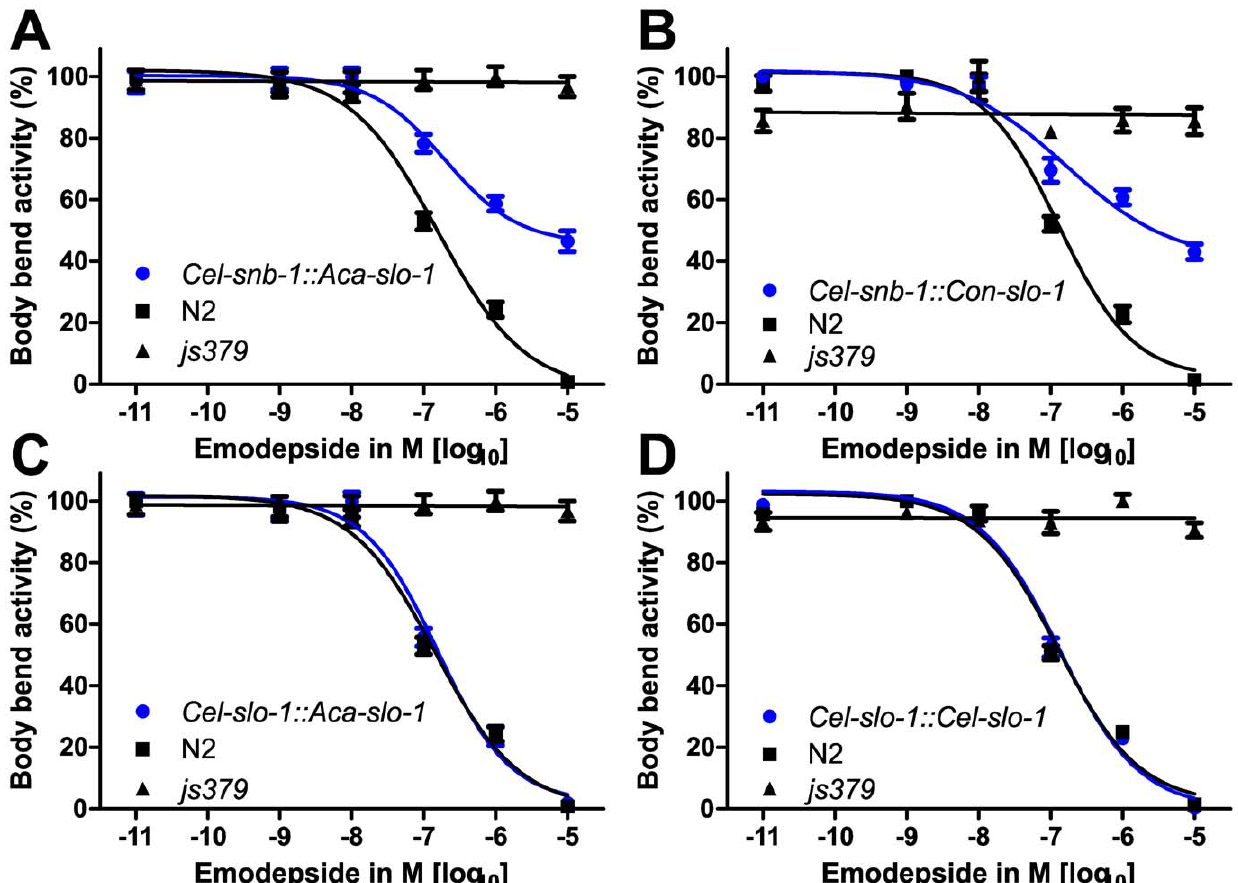
Figure 3. Parasite SLO-1 expressed from C.elegans promoters recover emodepside susceptibility in resistant slo-1 loss-of-function mutants. Body bend activity in percent (relative to the highest number of body bends in that group) of young adults after 24 h exposure to N emodepside. Comparison of wild-type N2, emodepside-resistant strain slo-1(js379) , and transformed slo-1(js379) lines. Error bars represent standard ) represent transformed lines, squares ( & ) N2 Bristol wild-type strain, triangles ( m ) js379(slo-1) mutant strain. (A) Cel-snb- errors of the mean. Dots ( 1::Aca-slo-1 , line expressing A. caninum slo-1 from the C. elegans snb-1 promoter. (B) Cel-snb-1::Con-slo-1 , line expressing C. oncophora slo-1 from the C. elegans snb-1 promoter. (C) Cel-slo-1::Aca-slo-1 , line expressing A. caninum slo-1 from the C. elegans slo-1 . (D) Cel-slo-1::Cel-slo-1 , C. elegans slo-1 expressed from C. elegans slo-1 promoter.